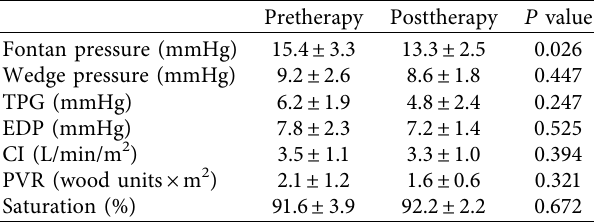
Table 2: Hemodynamic data.